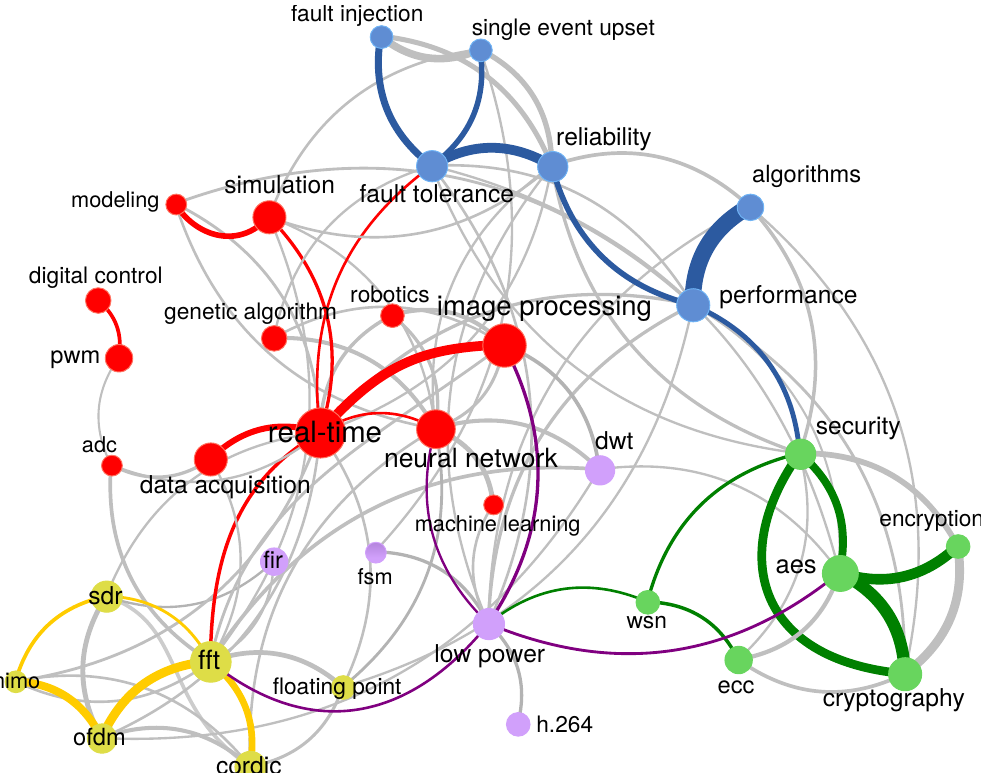
Figure 18. Co-occurrence network mapping of author keywords related to FPGAs’ applications. Colors represent groups of applications that are relatively strongly linked to each other. The size of the node signifies the number of documents related and the width of the lines represent the strength of the relationship between two